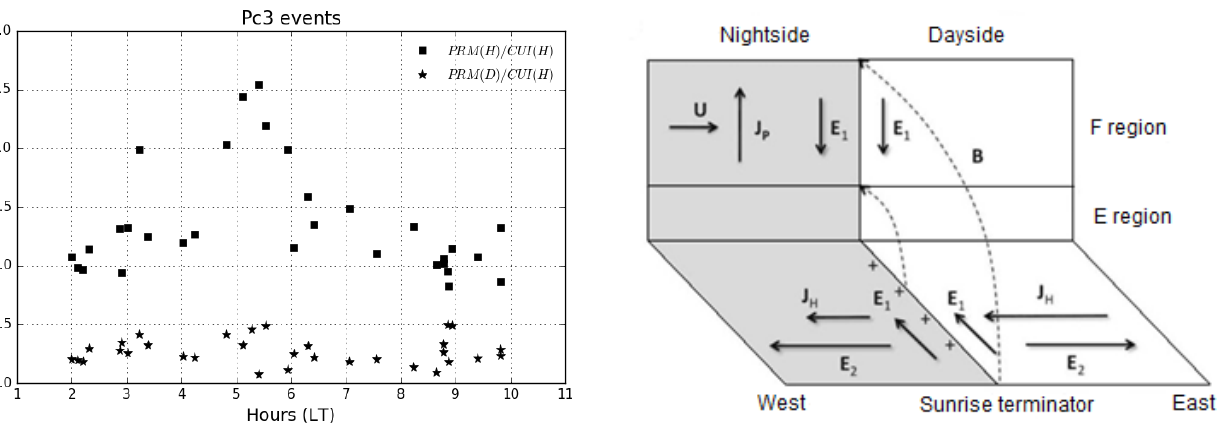
Figure 10. Distribution of Pc3 relative amplitudes between the PRM and CUI stations around sunrise. Squares are ratios of the H component between both stations (PRM/CUI), and stars are ratios between the D component of PRM and H component of CUI.